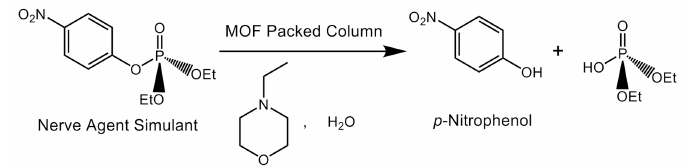
Scheme 1. Schematic illustration of the catalytic hydrolysis of CWAs under microflow